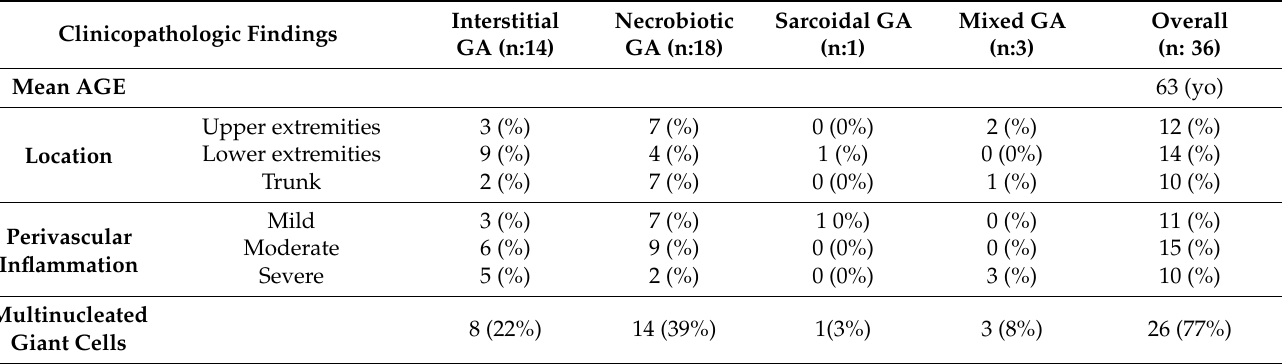
Table 3. Clinicopathologic findings of the control